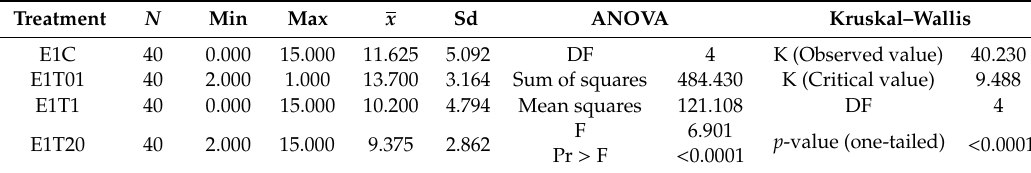
Table 4. Lethal time descriptive statistics and results of parametric and non-parametric statistical tests of differentiation between treatments in Experiment 1.